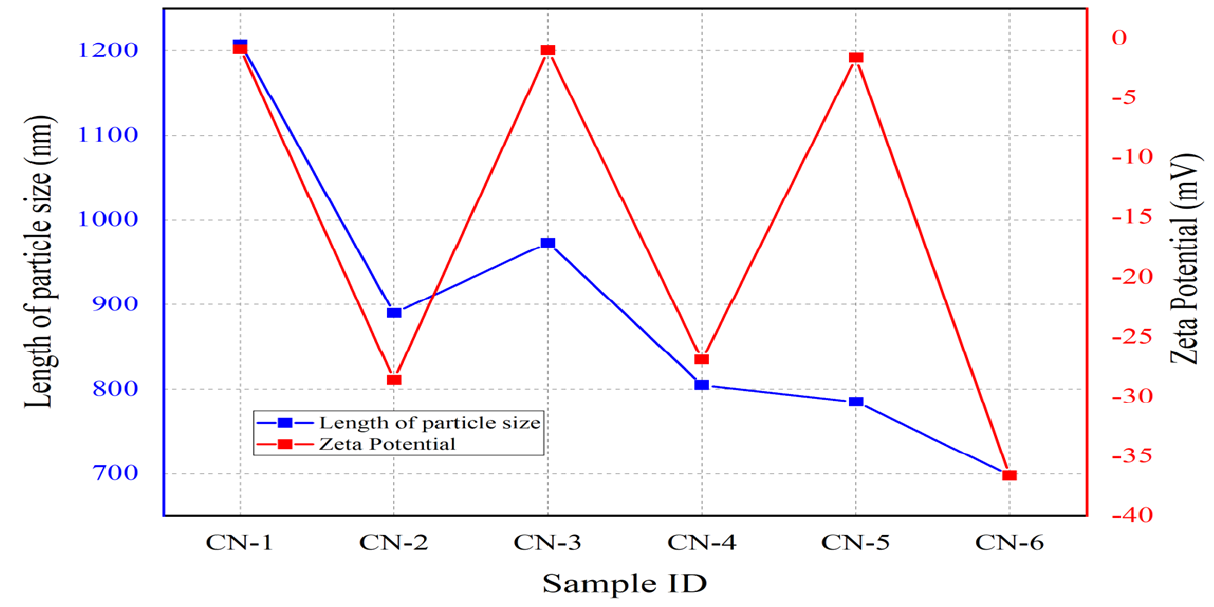
Figure 3. Nanocrystals’ length size and zeta potential correlation.